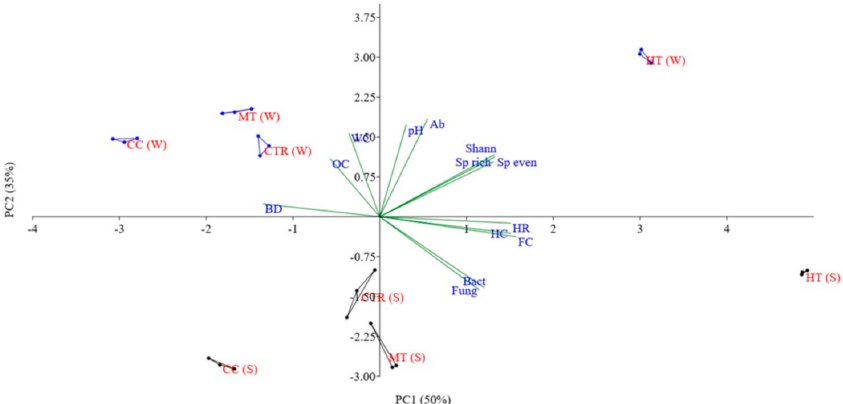
Figure 6. Principal component analysis (PCA) diagram of differently managed plots in a Pinus laricio plantation in two different seasons: summer (S) and winter (W). HT: intensive thinning; MT: moderate thinning; CC: clear cut; CTR: control; WC: water content, OC: organic carbon; HC: humic acid; FC: fulvic acid; HR: humification rate; Ab: total number of individuals; BD: bulk density; Fung: fungi; Bact: bacteria; Sp rich: species richness; Sp even: species evenness; Shann: Shannon–Wiener index of diversity. The triangles denote the groups (convex hulls) relating to the different silvicultural treatments, each consisting of n = 5